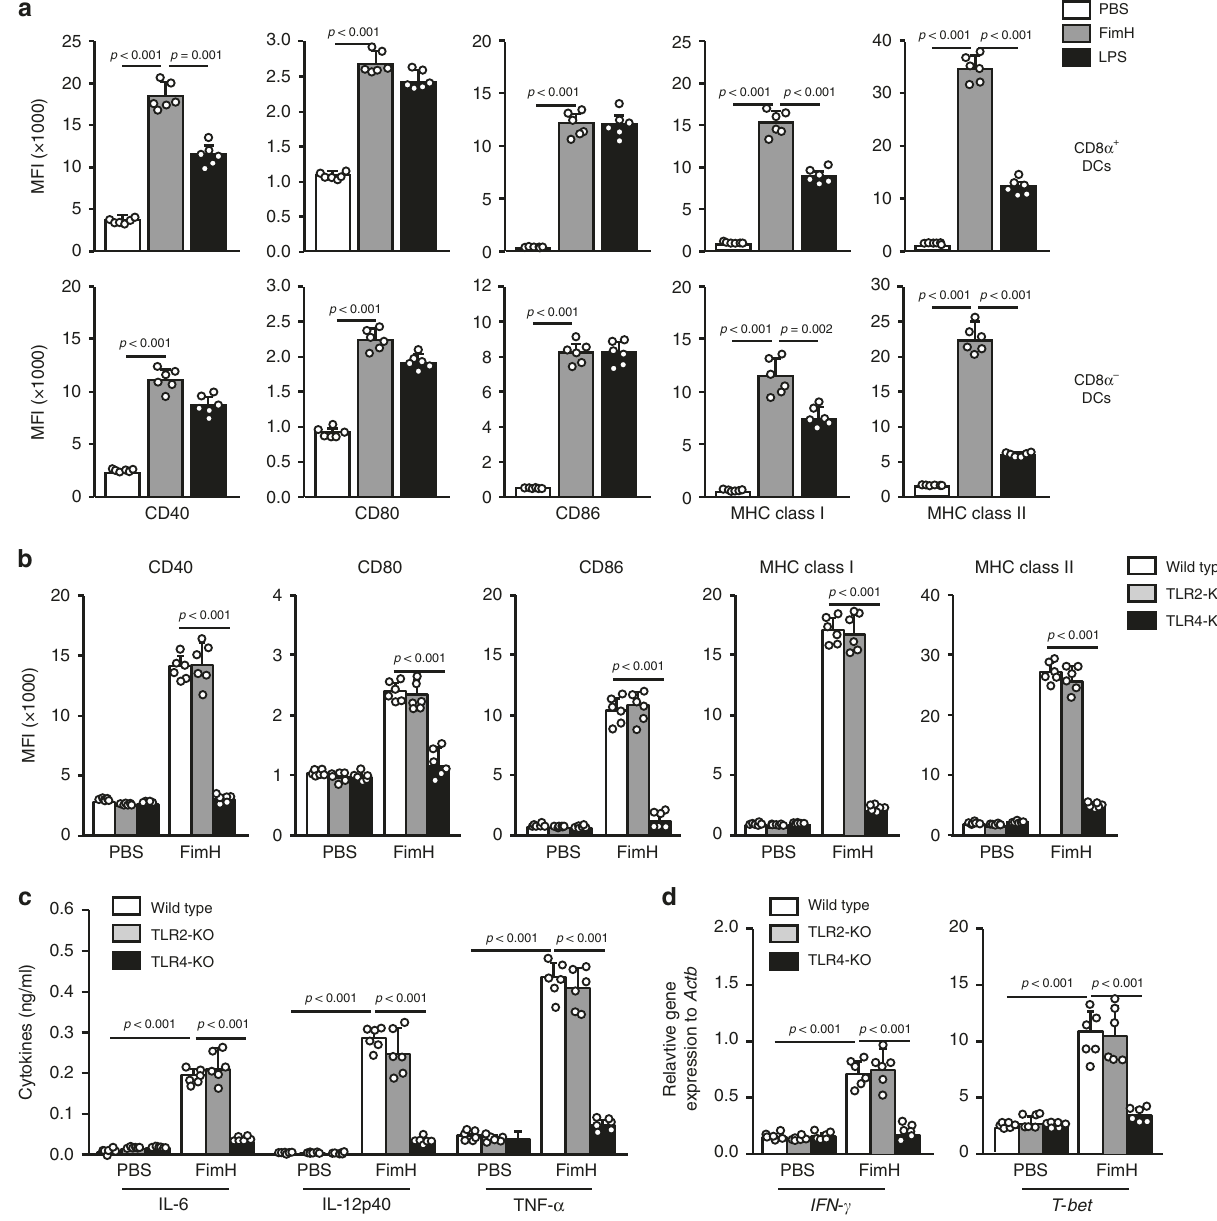
Fig. 1 FimH promotes the activation of DCs in inguinal lymph nodes (iLN) in mice in vivo. C57BL/6 mice were injected subcutaneously (s.c.) with 2.5 mg per kg of FimH and 1 mg per kg of LPS for 24 h, and the inguinal lymph nodes (iLN) were harvested. a The expression levels of costimulatory molecules and MHC classes I and II in CD8 α + DCs (upper panel) and CD8 α − DCs (lower panel) are shown. ( n = 6 mice, one-way ANOVA, mean ± SEM). b Flow cytometry analysis of costimulatory molecules and MHC classes I and II in iLN DCs from toll-like receptor 2 (TLR2)- and TLR4-knockout (KO) mice. ( n = 6 mice, two-way ANOVA, mean ± SEM). c Serum concentrations of IL-6, IL-12p40, and TNF- α in wild type, TLR2-KO and TLR4-KO mice are shown. ( n = 6 mice, two-way ANOVA, mean ± SEM). d Mean values of the mRNA expression levels in the iLN are shown. ( n = 6 mice, two-way ANOVA, mean ±